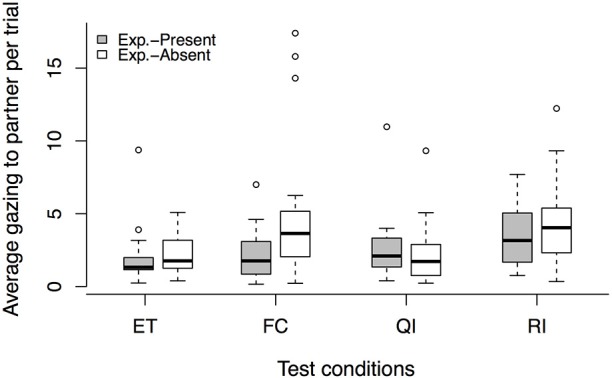
Average gaze duration to partner enclosure per trial in each test condition, comparing the experimenter-present (gray) with the experimenter-absent (white) buzzer task. Circles show outliers, black bars indicate median values, whiskers display upper and lower hinge, and boxes show the interquartile range. ET, equity; FC, food control; QI, quality inequity; RI, reward inequity; NR, no-reward control.